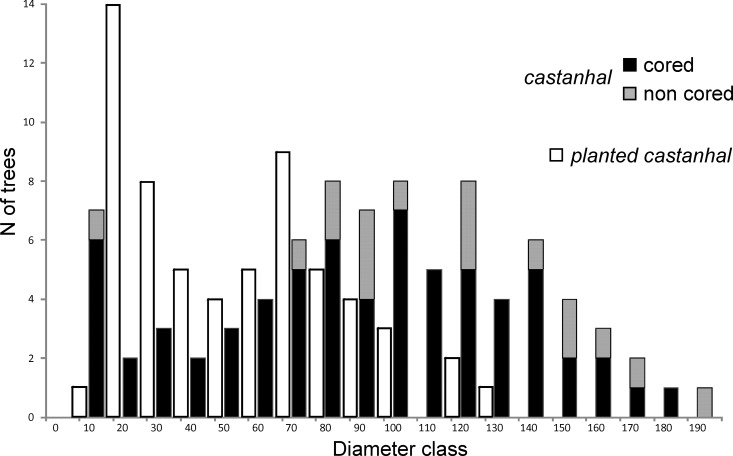
Frequency of Brazil nut trees by diameter class in the Purupuru Lake castanhal.Black bars represent the number of cored trees, gray bars represent the number of not cored trees, white bars represent trees in the planted castanhal that were not cored.